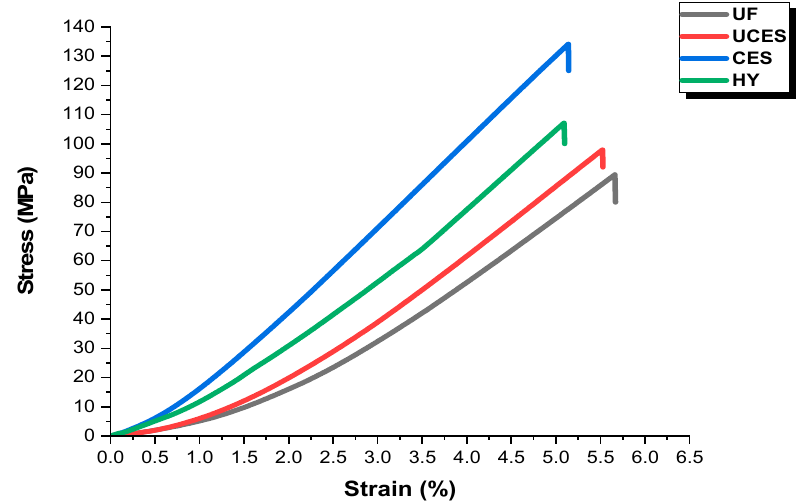
Figure 6. Stress–strain variation comparison of composite variants.